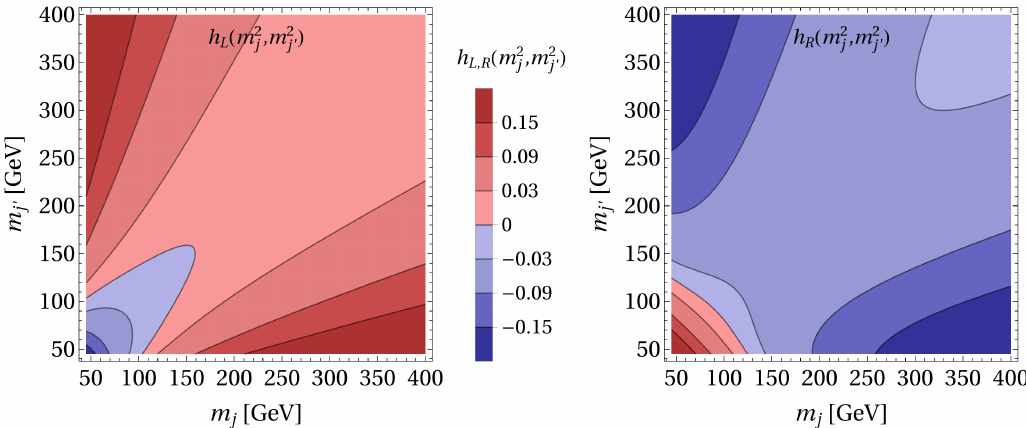
(cid:0) (cid:1) and m 2 , m 2 j j 0